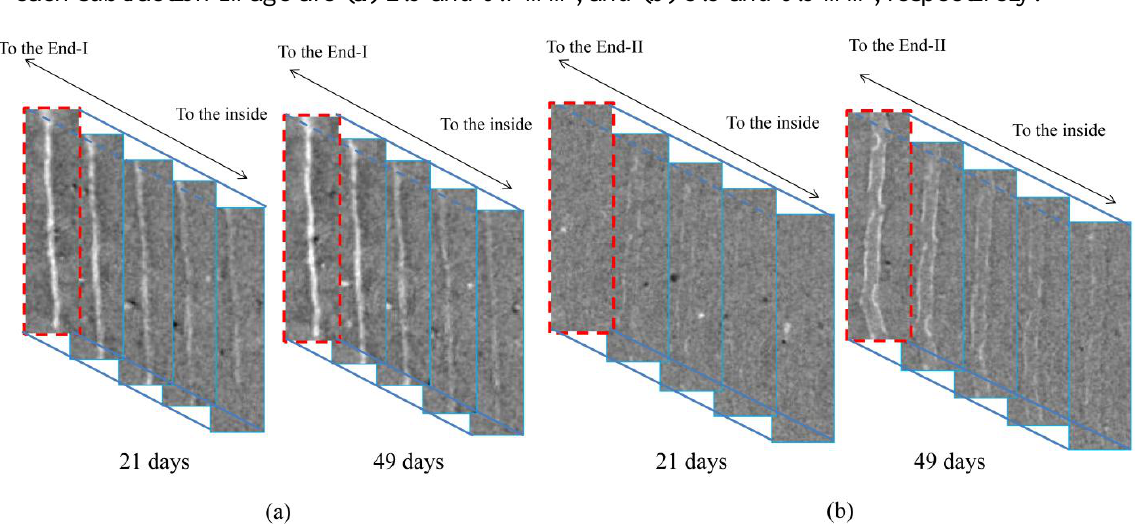
Figure 6. Subtraction images between initial images and those obtained after specimen was kept in seawater for 21 or 49 days for ( a ) End-I and ( b ) End-II. Height and width of each subtraction image are ( a ) 2.9 and 0.7 mm; and ( b ) 3.5 and 0.9 mm, respectively.